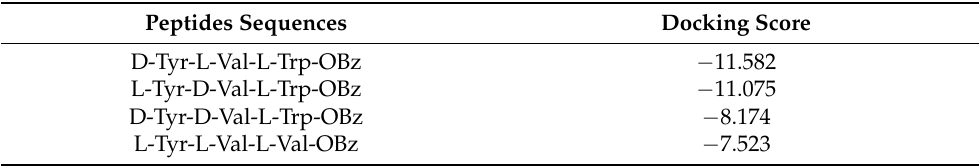
Table 2. Docking score values for the designed peptides based on the insertion of tryptophan in third position (second approach).